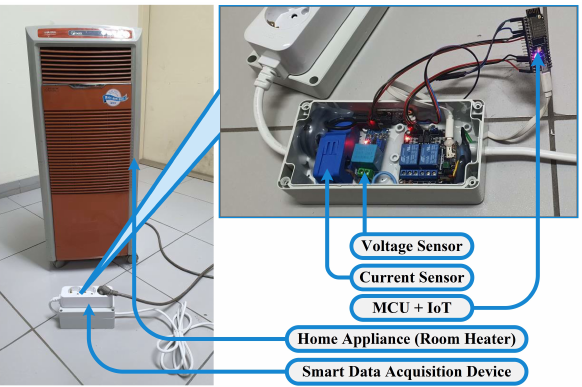
Figure 8. SDAD connection with a home